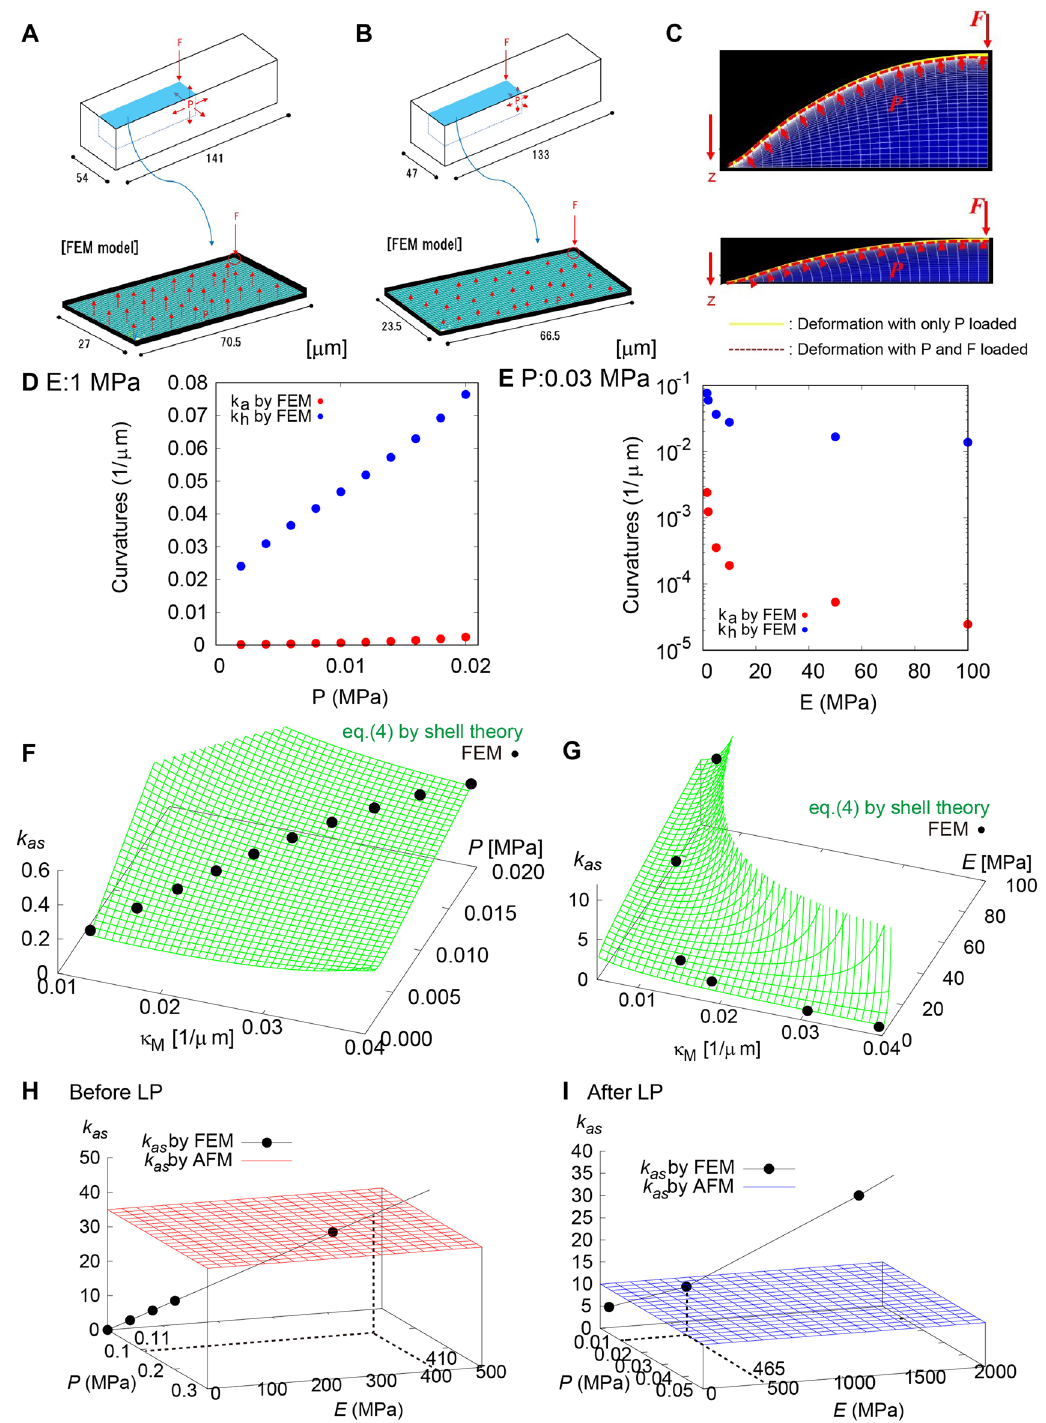
Figure 5. Verification of our theoretical results based on FEM simulation. ( A , B ) FEM model based on the actual cell surface geometry before ( A ) and after ( B ) LP. ( C ) Cell surface deformation before (top) and after (bottom) LP. Yellow and red lines are deformations with P and with P and F , respectively. ( D , E ) Axial curvature κ a and hoop curvature κ h calculated as a function of turgor pressure P when E = 1.0 MPa ( D ) and as a function of Young’s modulus E when P = 0.03 MPa ( E ). ( F , G ) Apparent stiffness k as before LP calculated as a function of κ M and P when E = 1.0 MPa ( F ) and as a function of mean curvature κ M and E when P = 0.03 MPa ( G ). Black dots calculated by the FEM simulation are on green surfaces calculated using Eq. (4). ( H , I ) Estimation of E and P using k as measured before ( H ) and after ( I ) LP. Black dots calculated by the FEM simulation are interpolated using Eq. (4) (black line). Dots on the red and blue planes in ( H ) and ( I ) indicate E and P , respectively, in agreement with k as quantified using the AFM